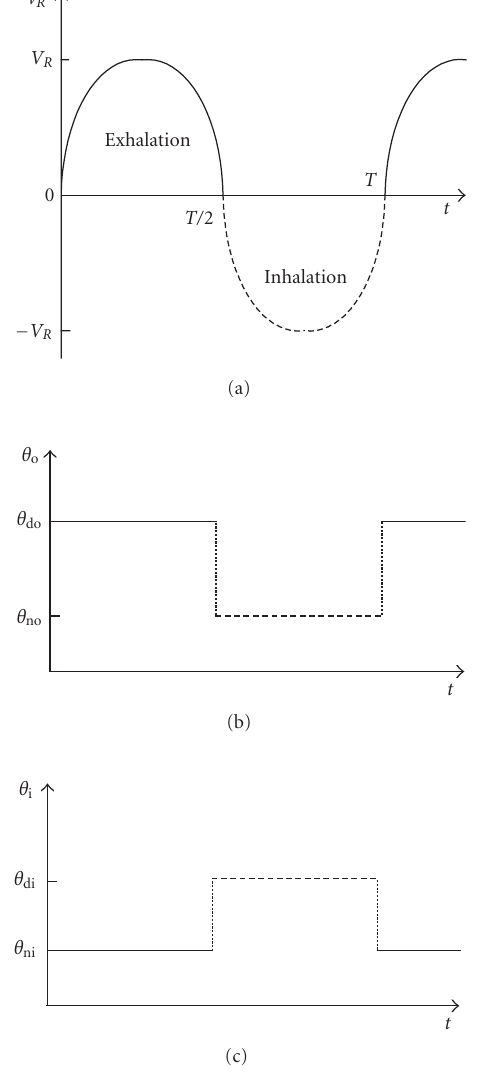
Figure 4: Behavior of pitch-controlled guide vanes. (a) Radial flow velocity. (b) Pitch angle of outer guide vane. (c) Pitch angle of inner guide vane.